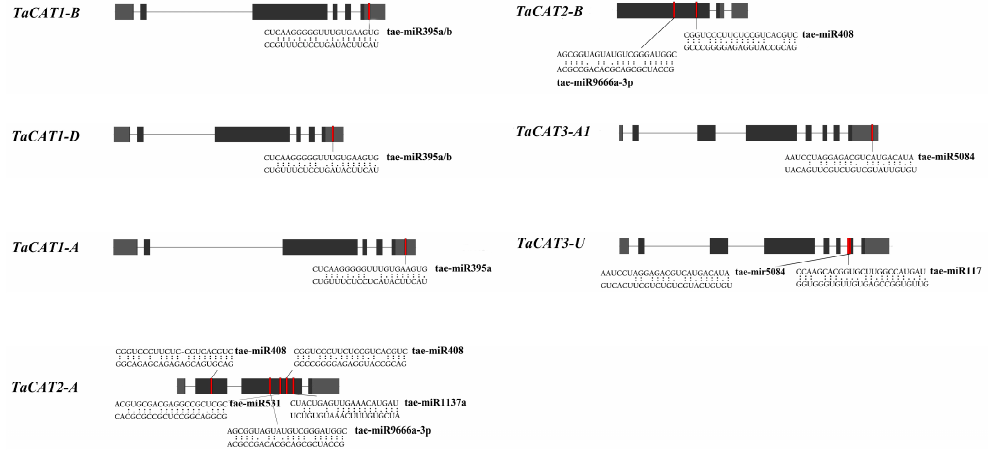
Figure 9. Analysis of miRNA targeting TaCAT genes in wheat. The heavy grey boxes represented the UTR regions and the black boxes were the exons. The miRNA complementary sites were shown in red boxes. The sequences of the miRNA and the complementary TaCAT sequences were shown in the expanded regions.